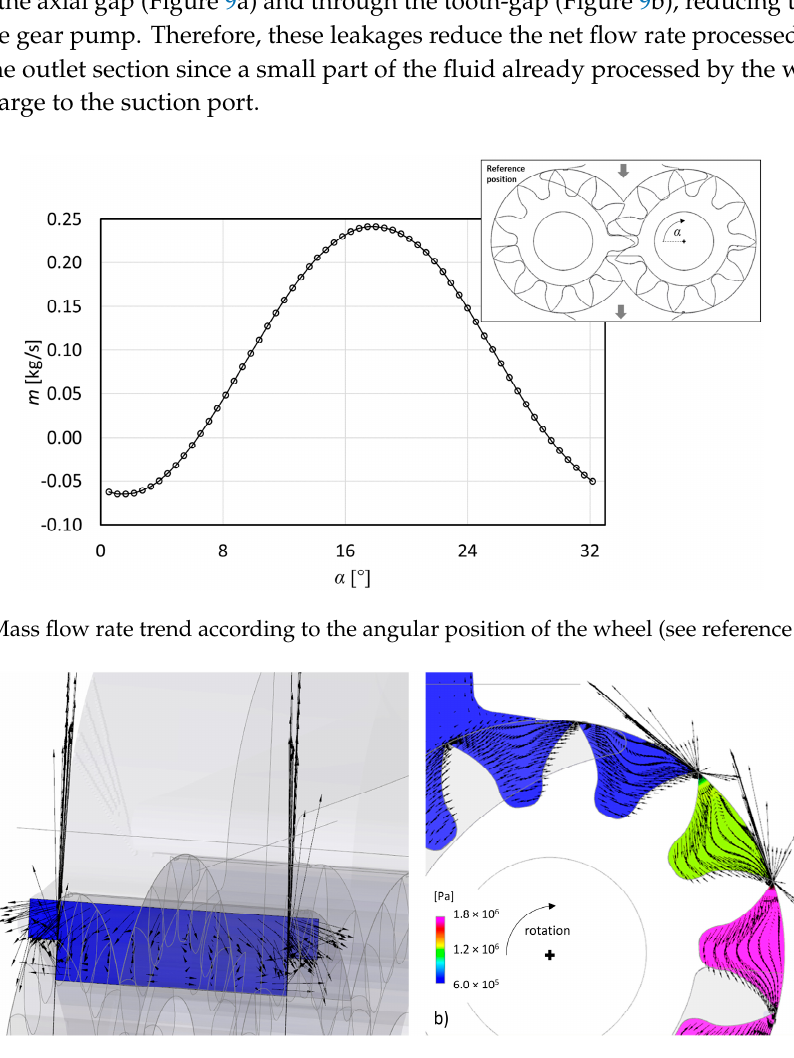
Figure 9. Velocity vector in the gaps: ( a ) tooth-flank gap and ( b ) tooth-head gap.